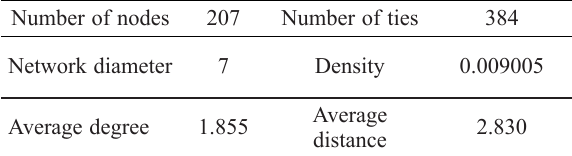
Table 2. Descriptive